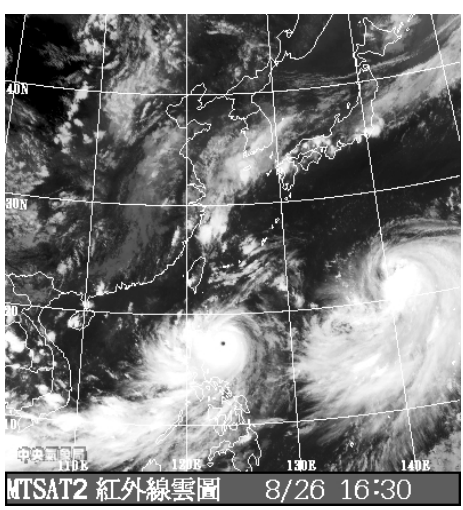
Figure 10. Infrared (IR) image recorded at 0830 UTC on 26 August 2011.